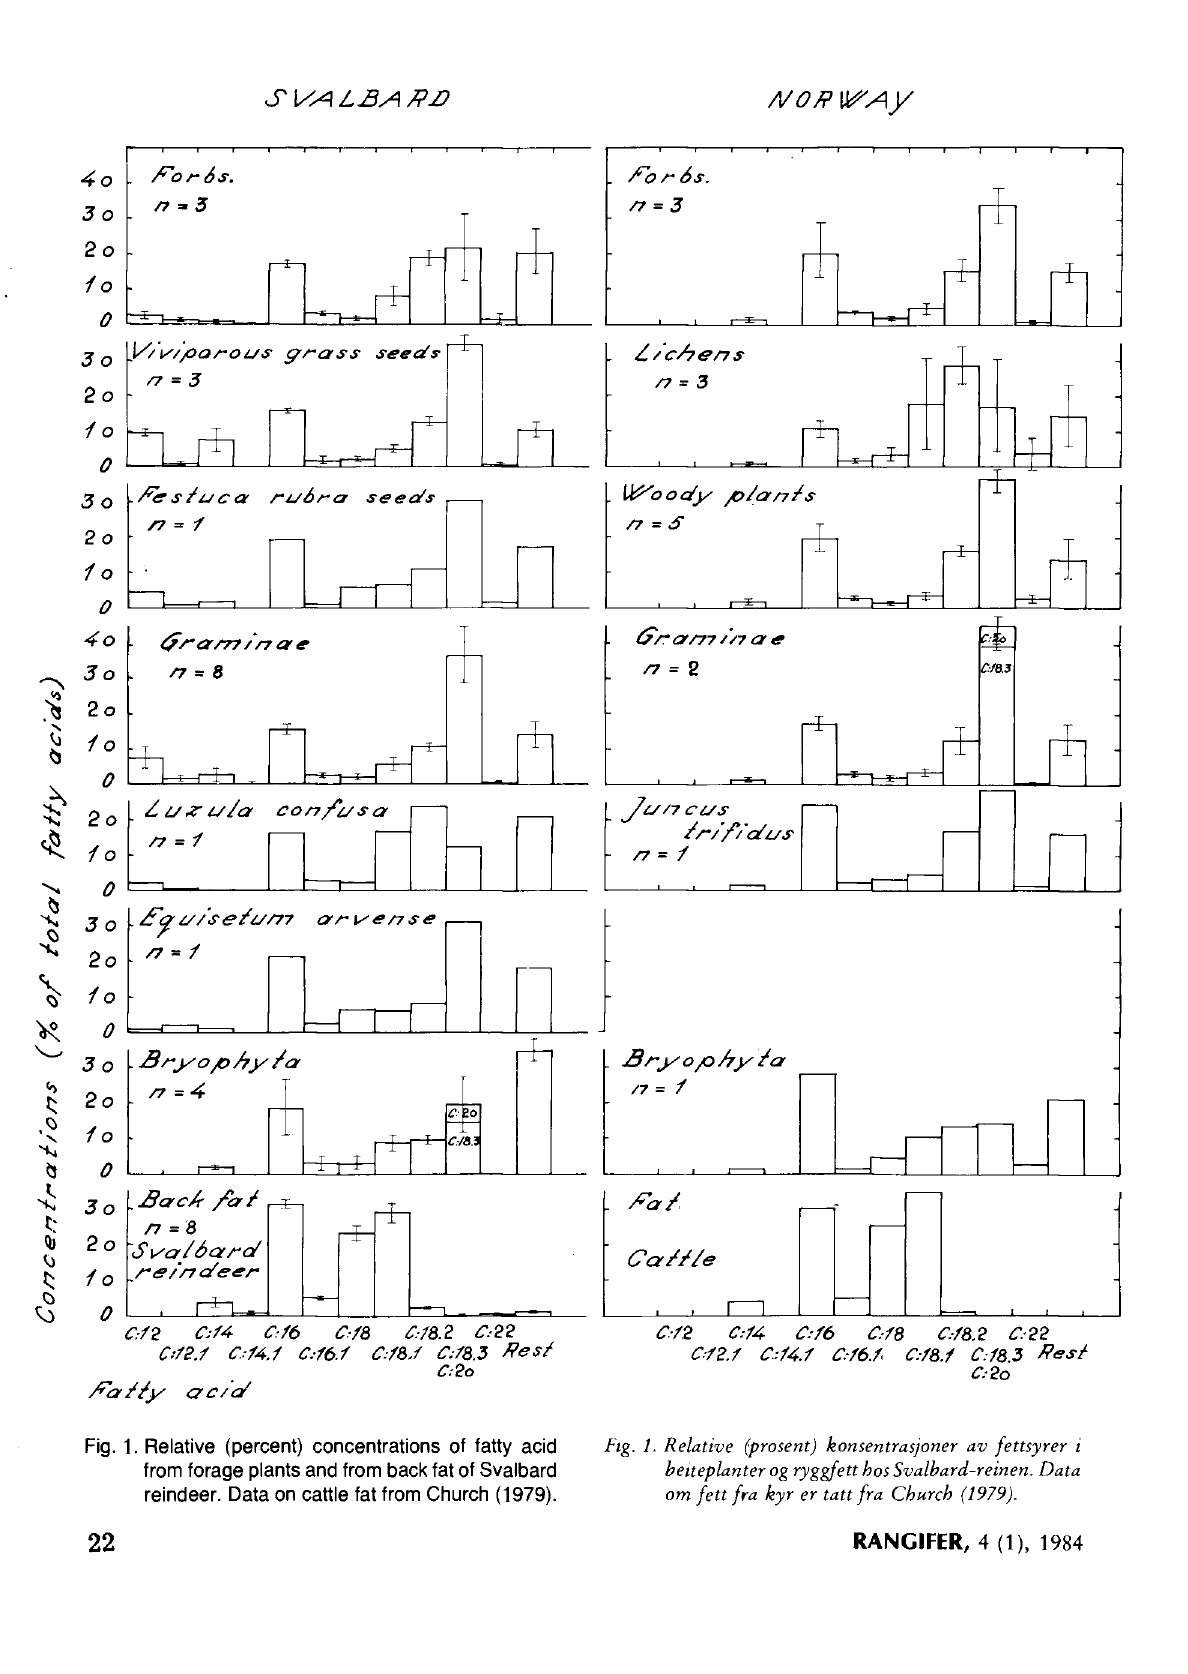
fig. 1. Relative (prosent) konsentrasjoner av fettsyrer i beiteplanter og ryggfett hos Svalbard-reinen. Data om fett fra kyr er tatt fra Church